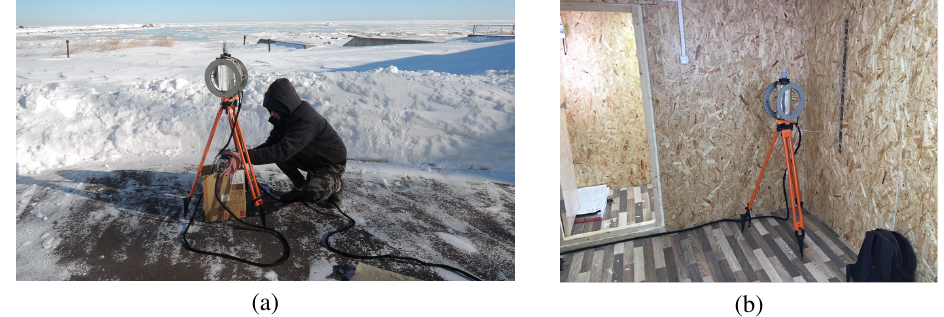
Figure 6. Magnetometer POS-4 in the TRANSARCTIC-2019 expedition: (a) the testing at the Ladoga field base of AARI; (b) a magnetometer sensor in a non-magnetic pavilion on